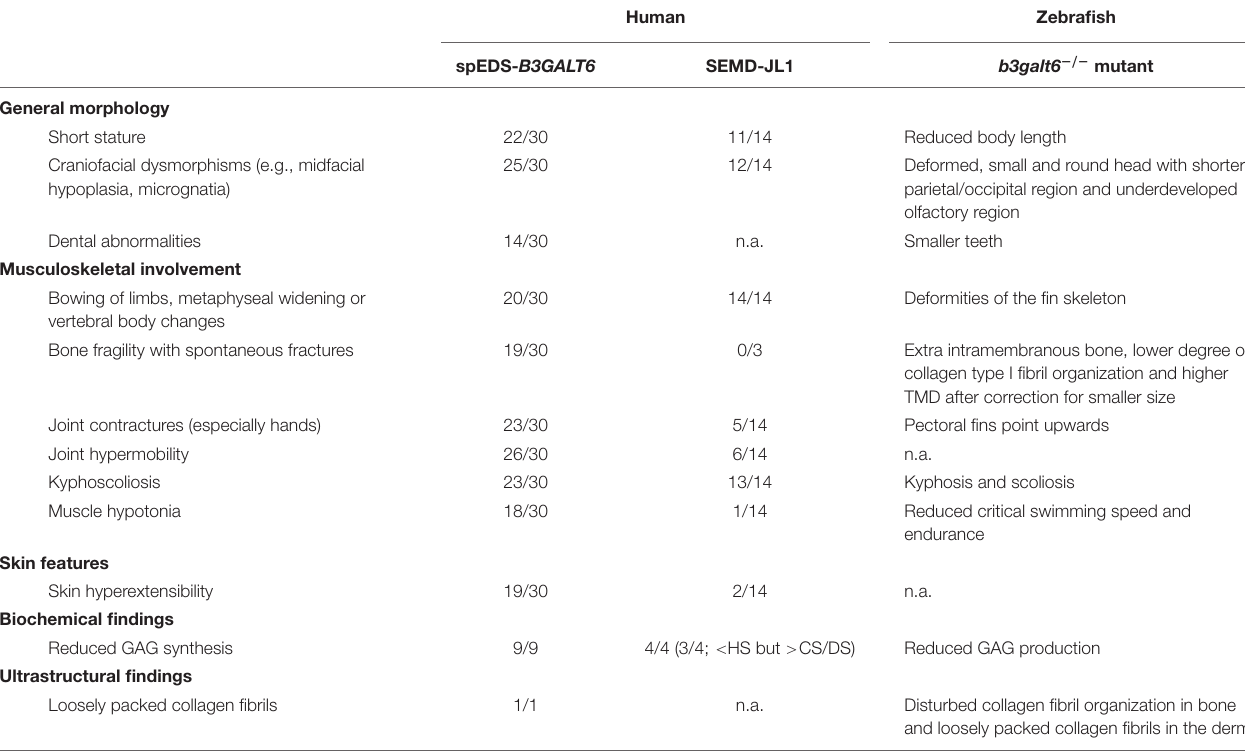
TABLE 2 | Clinical features and ultrastructural and biochemical abnormalities observed in spEDS- B3GALT6 and SEMD-JL1 individuals compared to the b3galt6 − / − zebrafish